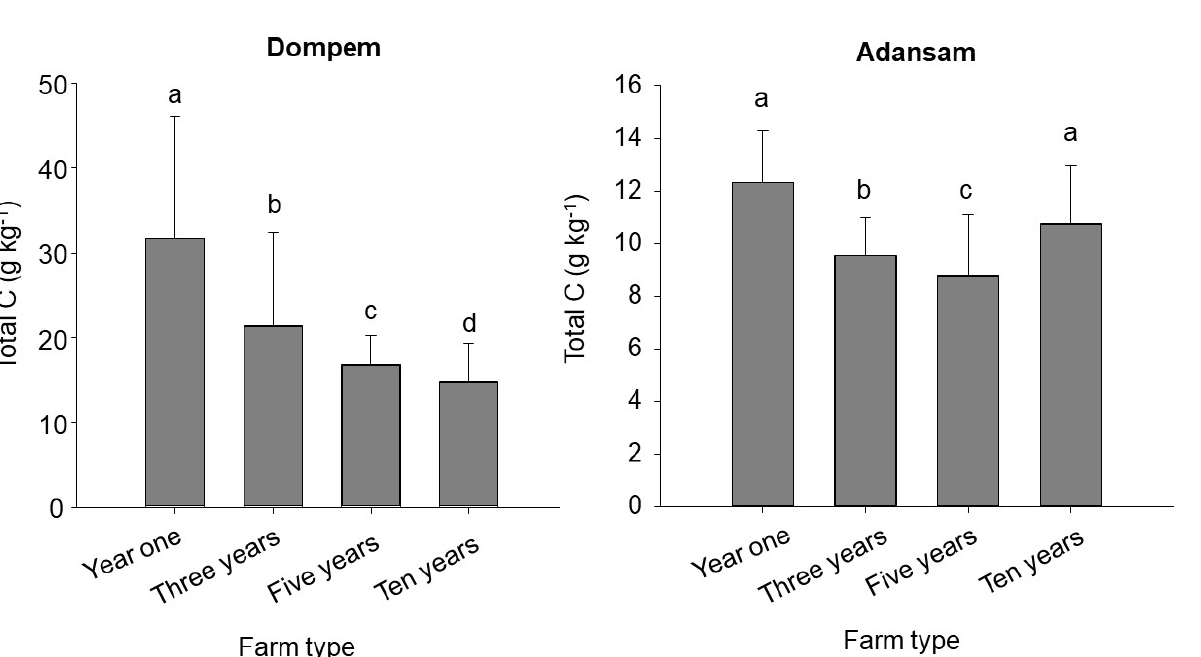
Figure 4. Available P contents in soils of Dompem ( p > 0.05; n = 9 ± one standard deviation) and Adansam ( p > 0.05; n = 11 ± one standard deviation).